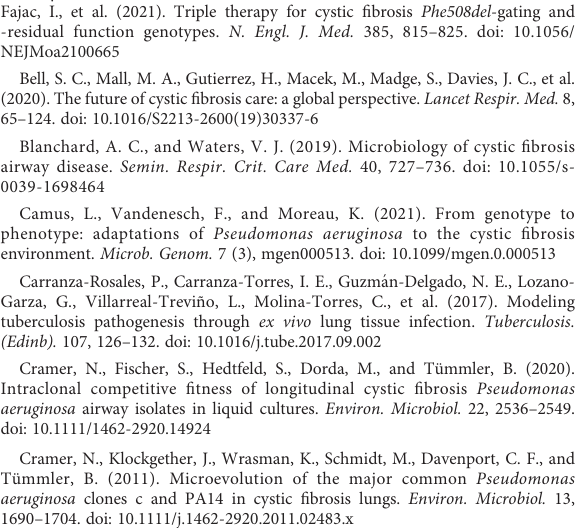
isolates. All isolates were distributed into three different groups (early, intermediate and late isolates) depending on colonization time (see Table S5) and tested against each other. In case of statistics with more than two groups Kruskal-Wallis was used, all two-group comparisons were executed with Wilcoxon signed rank tests. All p-values are Bonferroni corrected and marked in red if mentioned in the body of the manuscript. SUPPLEMENTARY TABLE 5 Distributions of clonal P. aeruginosa isolates separated by colonization time into three groups. (A) shows the results for mPCLS, (B) the results for hPCLS experiments. All sequential isolates were separated into three different groups depending on the colonization time. First isolates belonging to the fi rst quarter of colonization time, the late isolates to the last quarter. All isolates within the inner quartiles were classi fi ed as intermediate isolates. For statistical analysis Kruskal- Wallis was